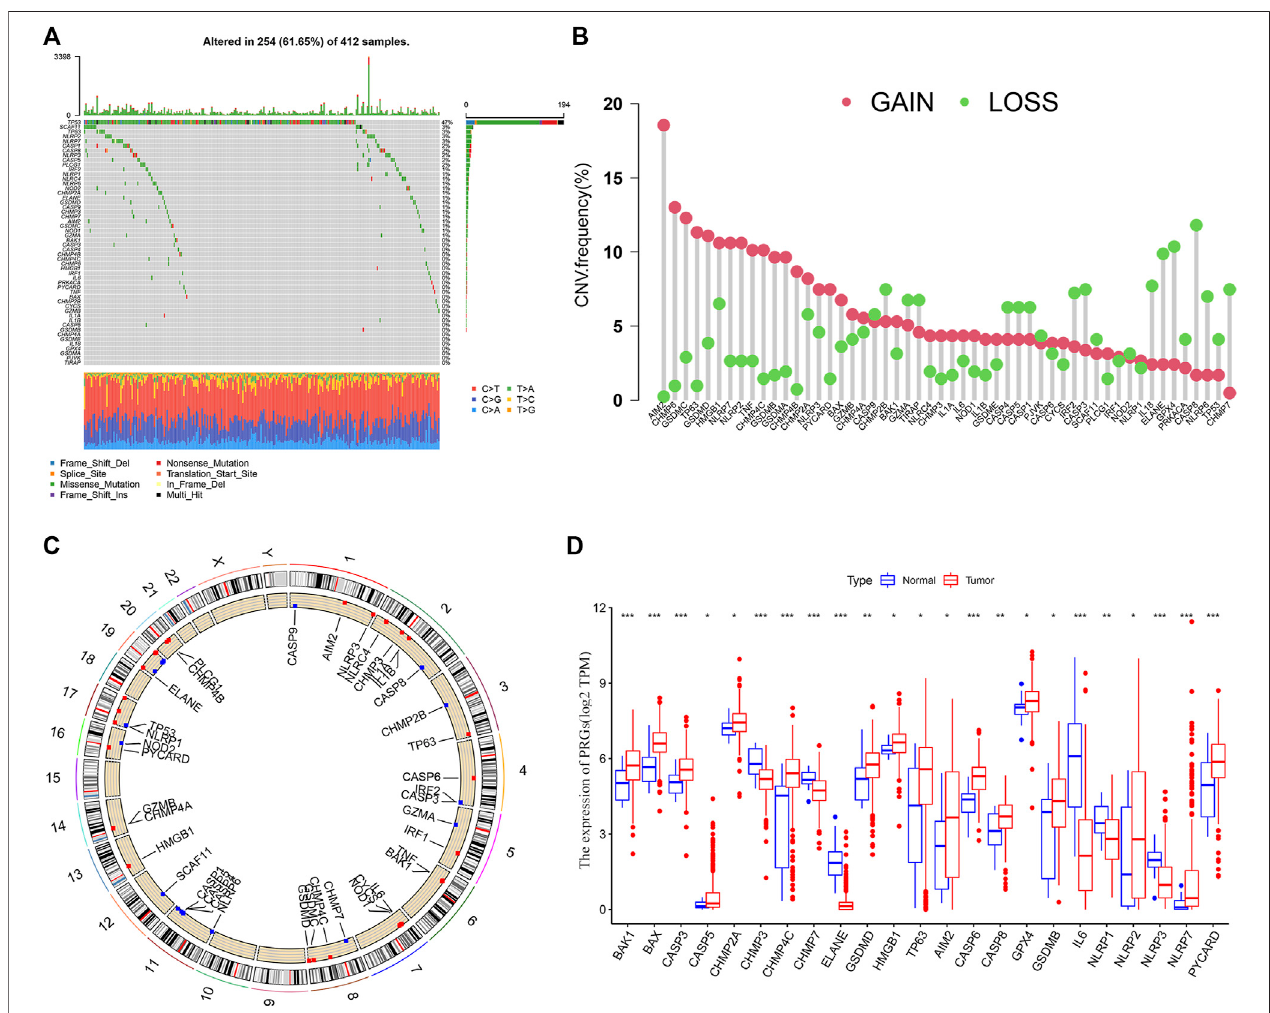
FIGURE 1 | Landscape of genetic and transcriptional alterations in bladder urothelial carcinoma. (A) Mutation frequency of 52 PRGs using the TCGA cohort. (B) CNVFrequencyof52PRGswithgainorloss. (C) LocationsofCNValterationinPRGson23chromosomes. (D) Thetranscriptionalexpressionofdifferentiallyexpressed genes (DEGs). *p < 0.05, **p < 0.01, and ***p <